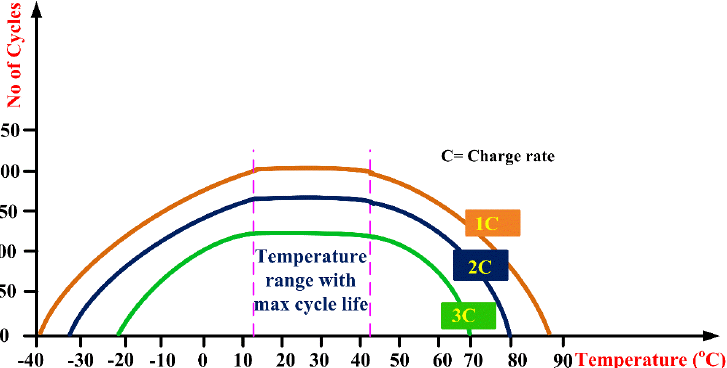
Figure 16. Battery cycle life vs. temperature at a dissimilar charge rate of Li-ion battery [58]. Table 13. Challenges, causes, and recommendations to monitor the SOC.